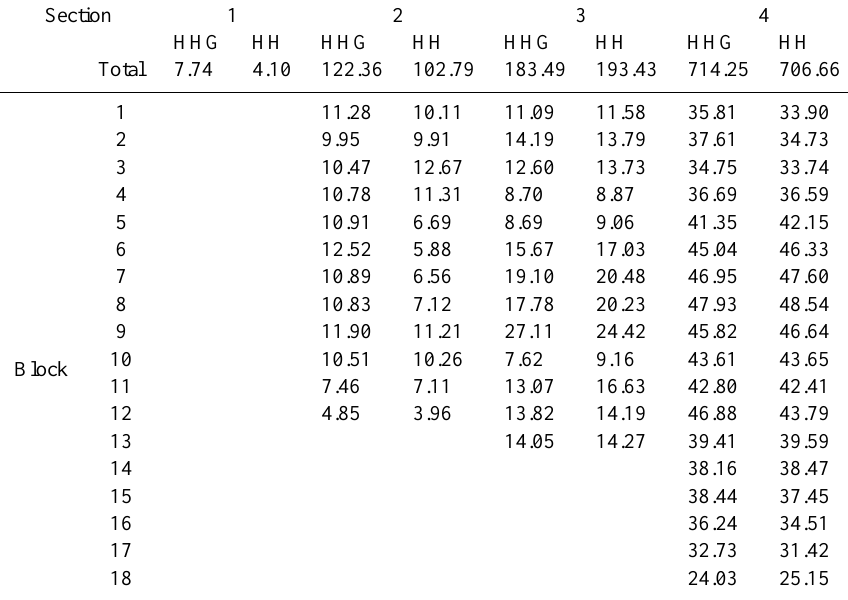
Table 7. Values for the flooded areas (ha) in Sects. 1, 2, 3 and 4 obtained using the historical and hydrogeomorphological method (HHG) and the hydrologic-hydraulic method (HH) – total and for each 200m block